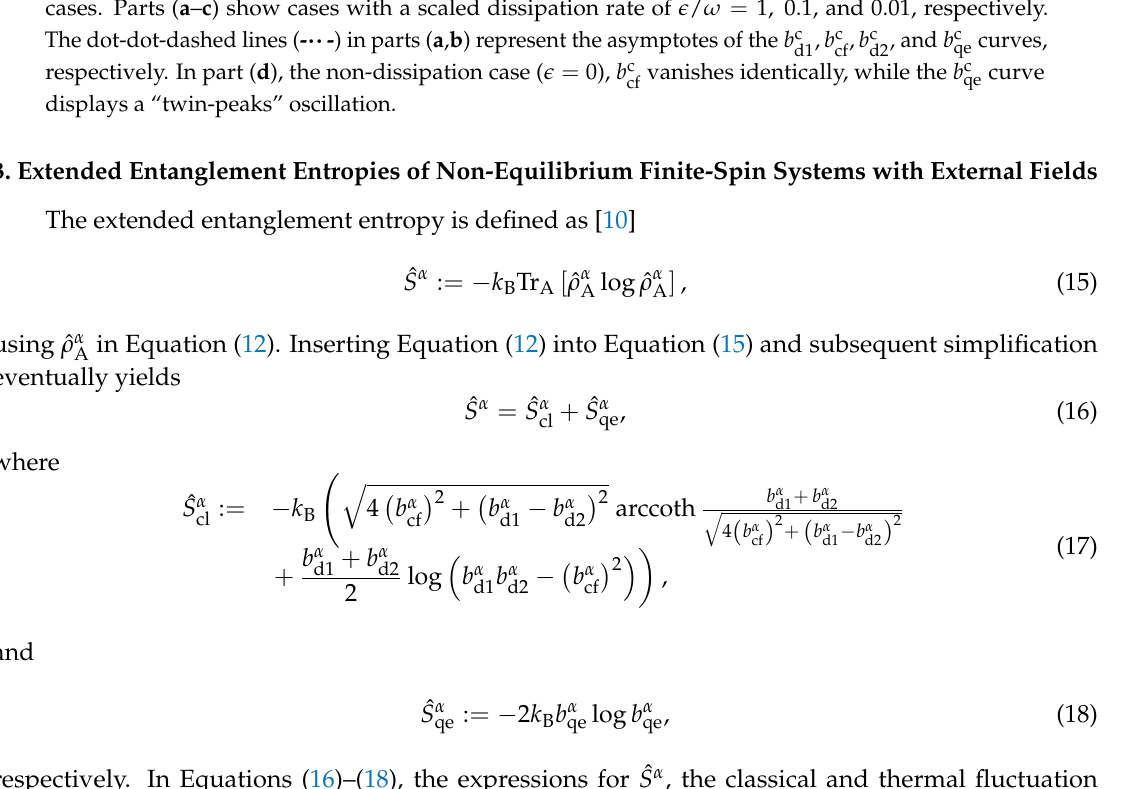
- ) in parts ( a , b ) represent the asymptotes of the b c ··